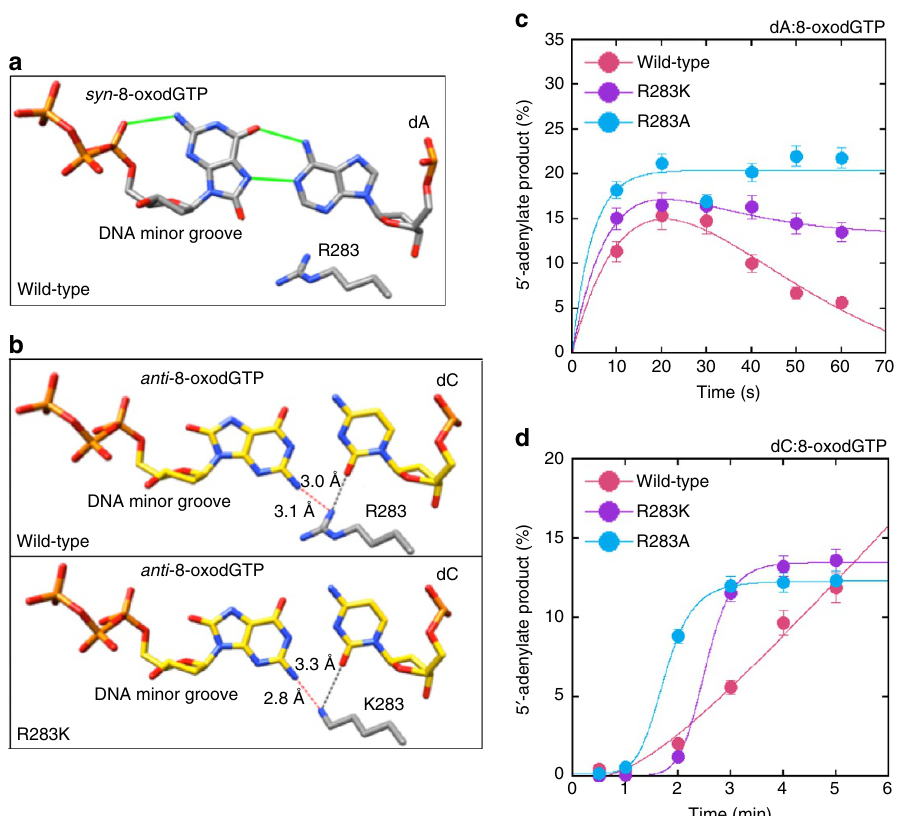
Figure 4 | Comparison of ligation failure for pol b active site mutants R283A and R283K. Structural images show pre-catalytic ternary substrate complex with 8-oxodGTP as the incoming nucleotide opposite template bases A ( a ) and C ( b ) in a single-nucleotide gap. Plots show differences in the products of 5’-adenylation between wild type and pol b mutants for the substrates A gap ( c ) and C gap ( d ). Time-dependent changes in insertion and ligation products are presented in Supplementary Fig. 5. The data represent mean values with the s.d. from three independent